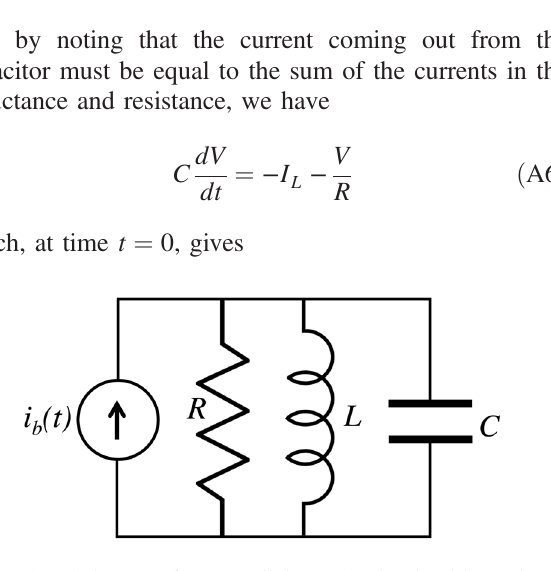
FIG. 19. Scheme of a parallel RLC circuit driven by a ð t Þ current i b